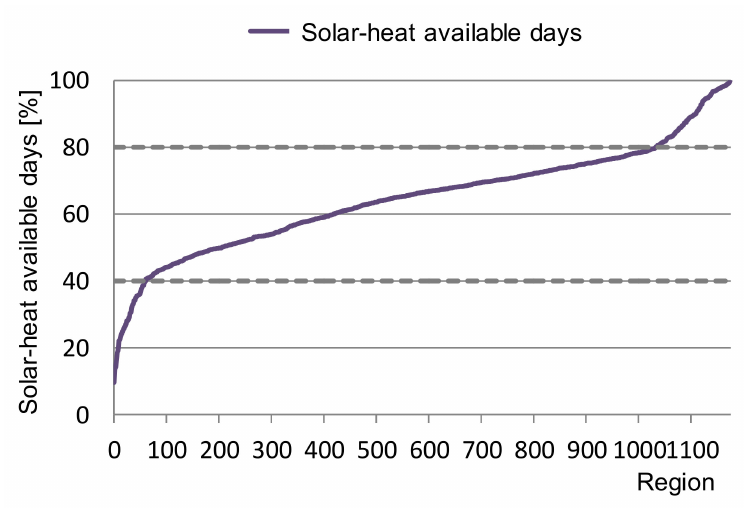
Figure 5. Ratio of solar-heat available days to days required for heating.